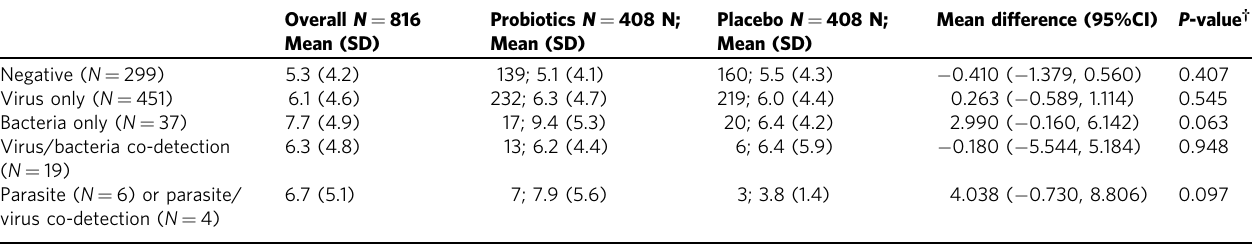
Table 2 Primary outcome – modi fi ed Vesikari scale score by treatment and pathogen